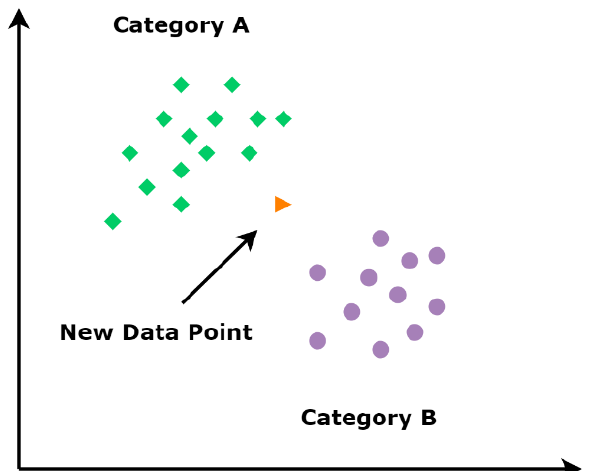
Figure 4. k-Nearest neighbor.